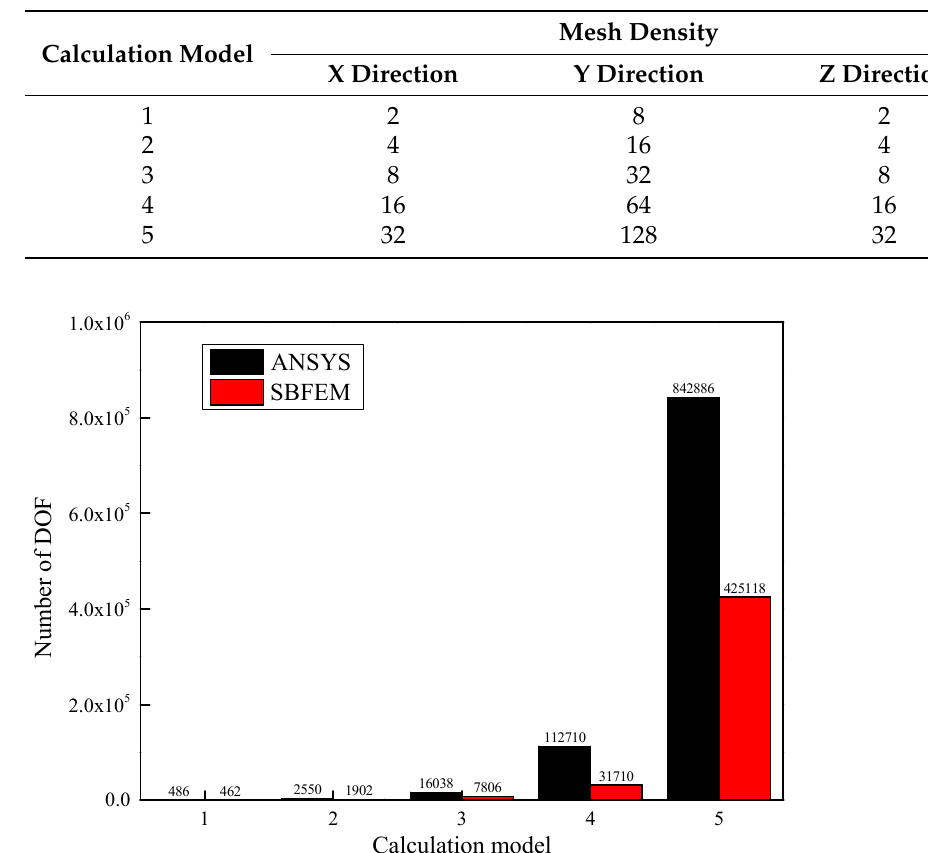
Table 1. The mesh density in different directions of each block.